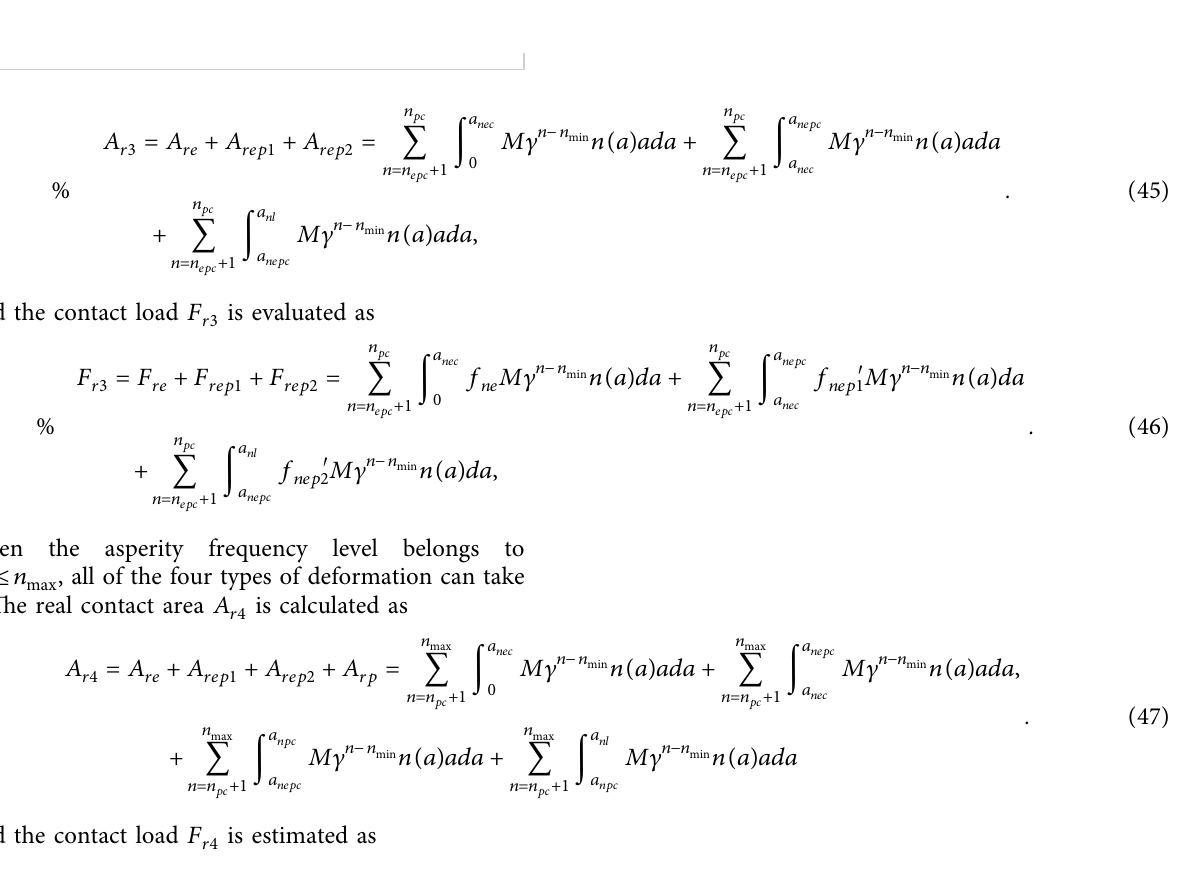
Figure 5: Comparison of the proposed model and the MB model on the critical contact areas and the largest contact area at different asperity frequency levels ( A r / A a � 0 .